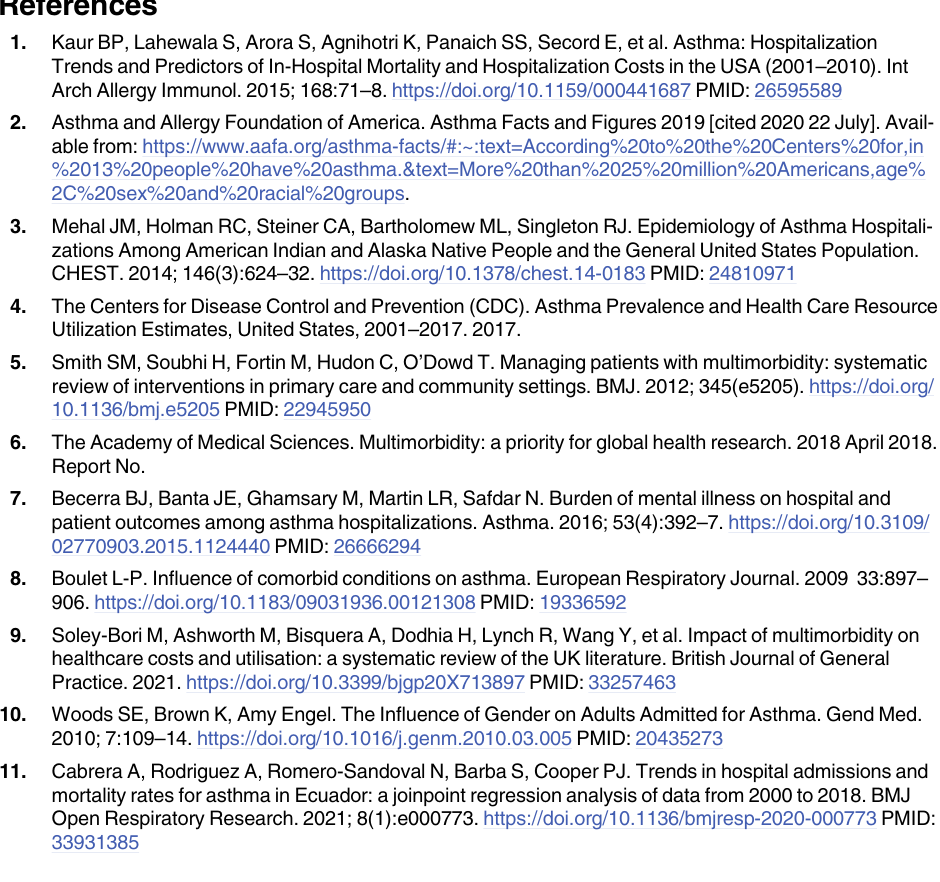
S2 Fig. Trends of in-hospital mortality by age of death, gender, race and asthma severity in patients admitted with asthma between 2004 and 2017. S3 Fig. Assessment of asthma admissions before and after the ICD code switch by calendar quarters